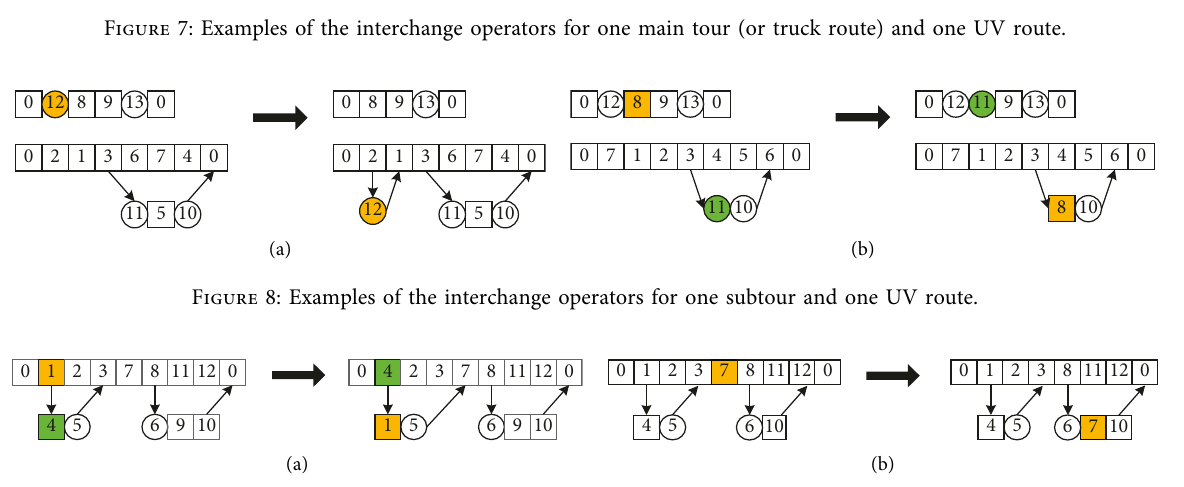
Figure 9: Examples of the interchange operators for one main tour (or truck route) and one